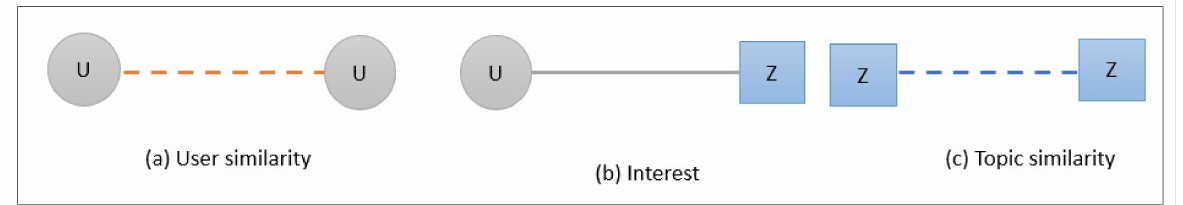
Figure 7. Link Types in Heterogeneous